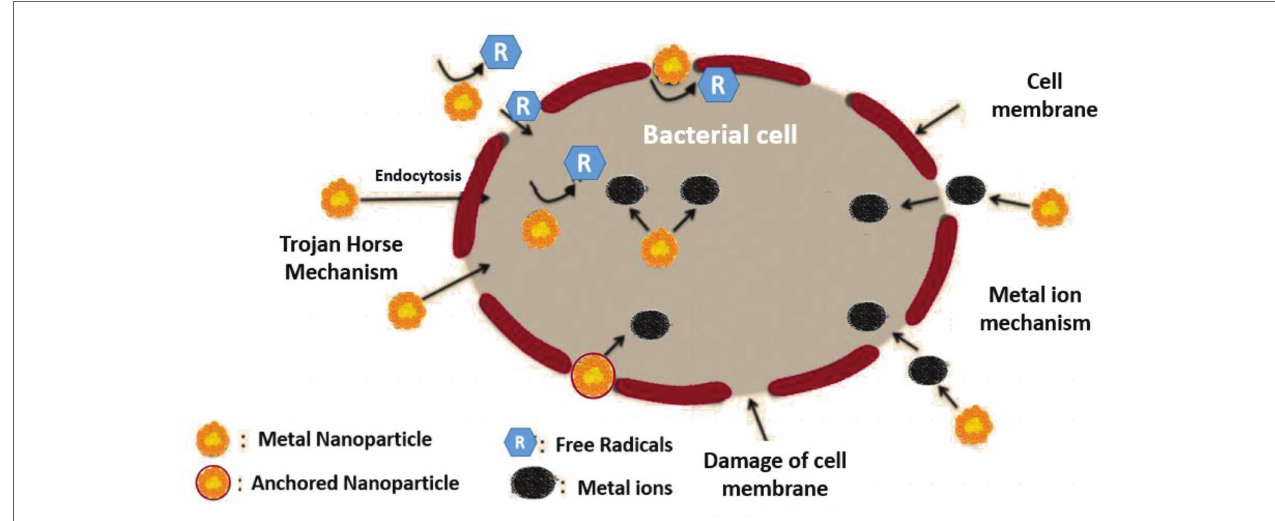
FIGURE 3 | Mechanism of NPs to bring about damage to the bacterial